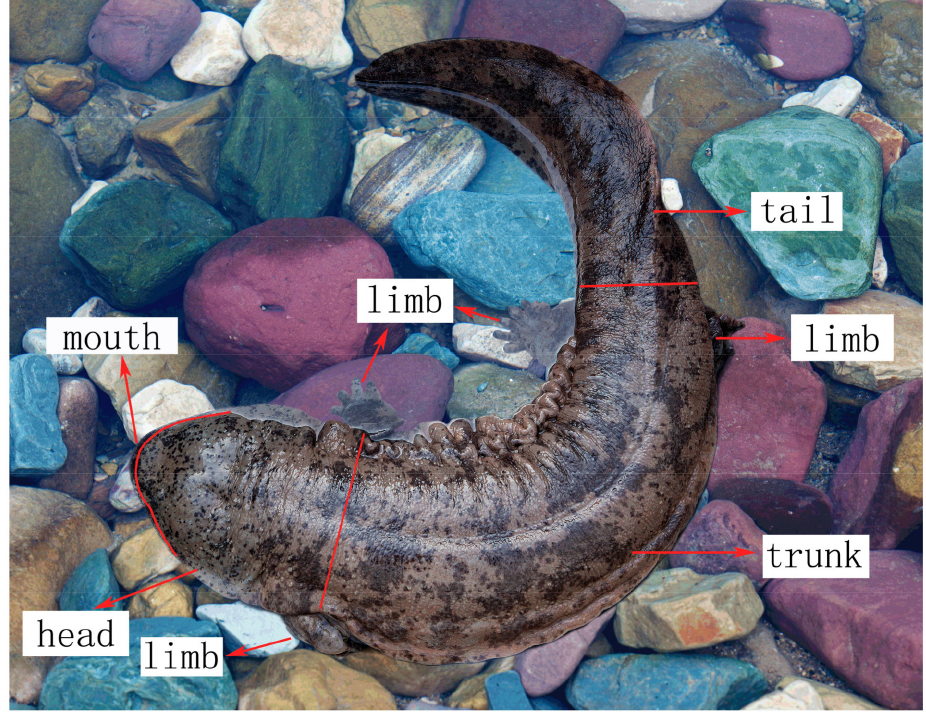
Figure 1. Body parts of Andrias davidianus